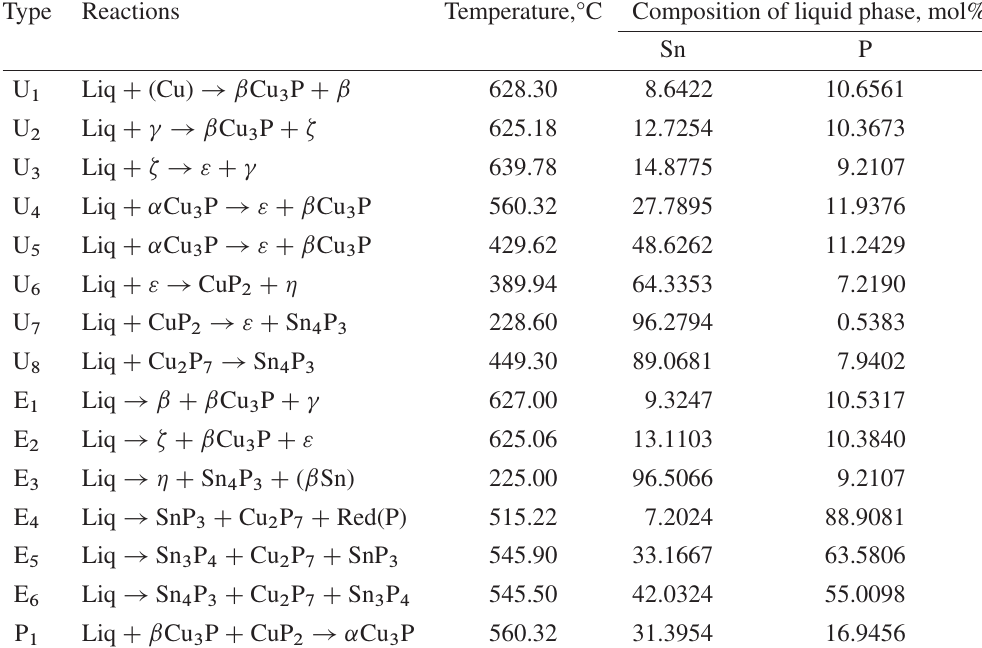
Table 4. Invariant equilibrium reactions related to the liquid